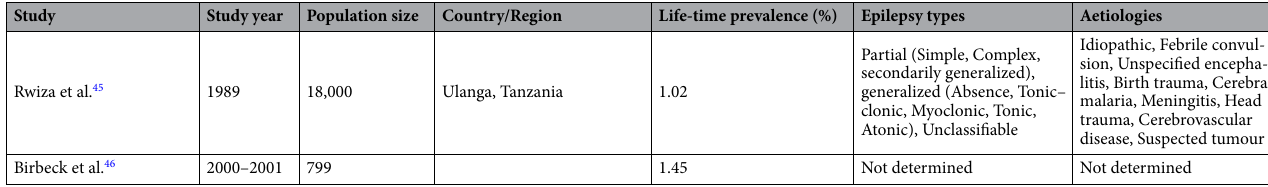
Table 5. A comparison of epilepsy life time prevalence in nationwide scale in other